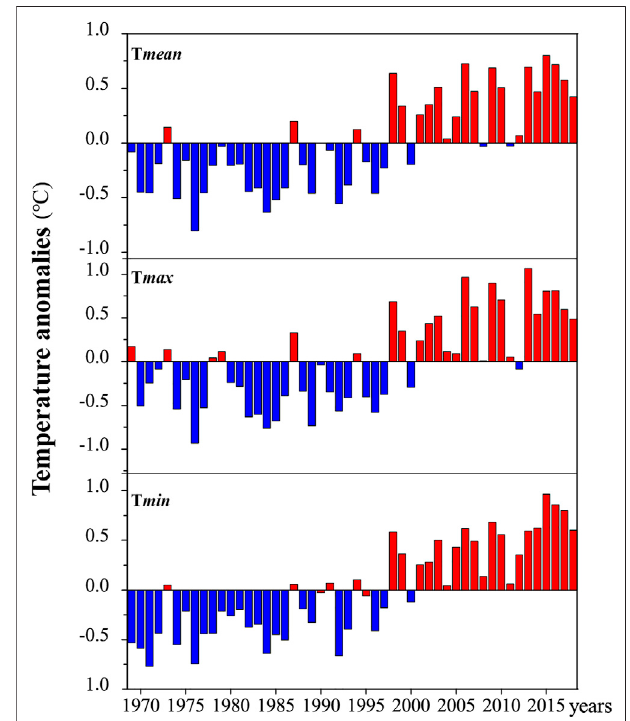
FIGURE3| AnnualvariationsofNSATanomaliesinSouthwestChinafor the period 1969 –